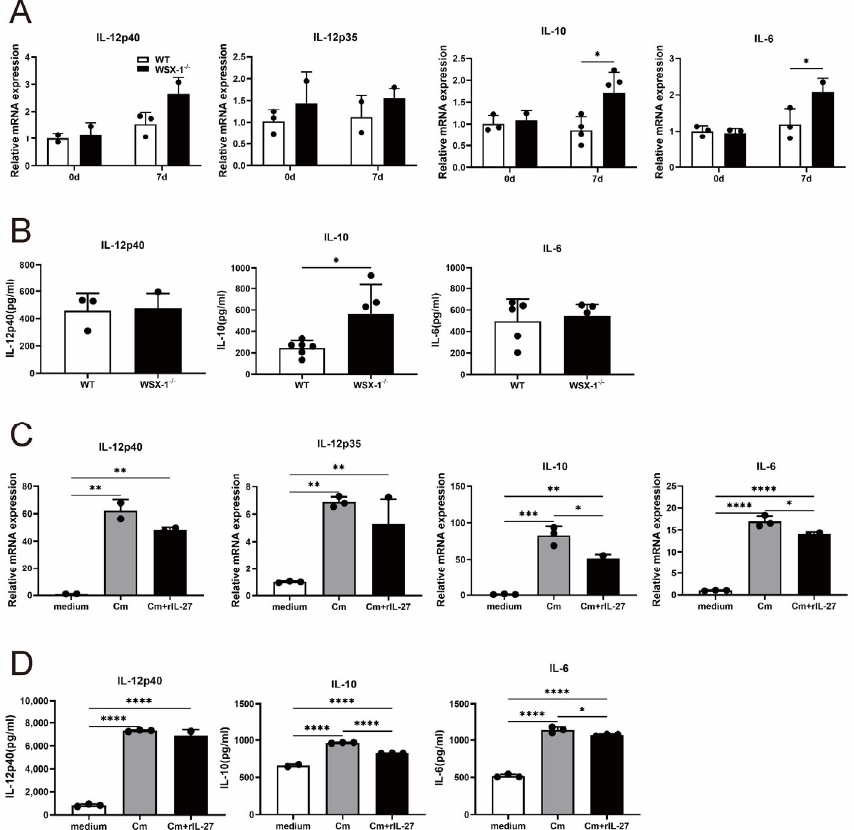
Figure 6. DCs cytokines production after WSX-1 deficiency or rIL-27 administration against C. muridarum infection. ( A , B ) The spleen DCs of WT and WSX-1 − / − mice on days 0 and 7 p.i. were sorted as described in the methods. The total RNA of sorted DCs was prepared for qPCR, and the mRNA expressions of cytokines IL-12p40, IL-12p35, IL-10, and IL-6 were shown ( A ). The culture supernatants of sorted DCs were prepared for ELISA, and IL-12p40, IL-10, and IL-6 productions in the culture supernatant were determined on day 7 p.i. ( B ). BMDCs were induced from naïve C57BL/6 mice, grouped as noninfected control BMDCs (white), Cm-infected BMDCs (grey), and Cm-infected BMDCs with rIL-27 administration (black), analyzed by qPCR ( C ) and ELISA ( D ) for cytokine pro- duction. Data are shown as means ± SD, representing one of three independent experiments (n = 3–6 /group/experiments). Statistical significances of differences are determined by two-way ANOVA